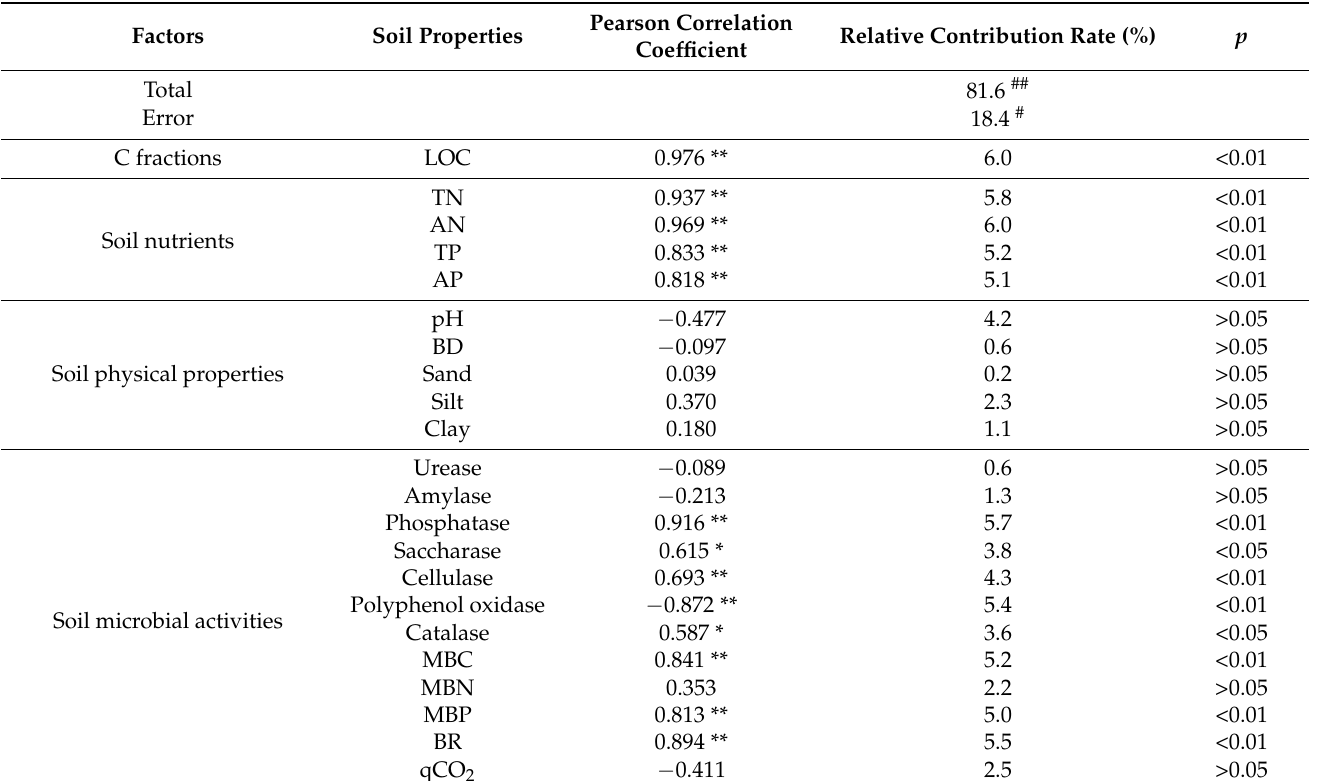
Table 3. Pearson correlation coefficient between soil organic carbon and other soil properties. Note: * Correlation is significant at the 0.05 level ( p < 0.05) (2 tailed) and ** Correlation is significant at the 0.01 level ( p < 0.01) (2 tailed). N = 15. ## indicates the value was the explain rates based on the coefficient of determination ( R 2 ) of the multivariable linear regression analysis; # indicate the residual contribution rate of the multivariable linear regression, which indicates other factor’s contribution to SOC that were not determined in this